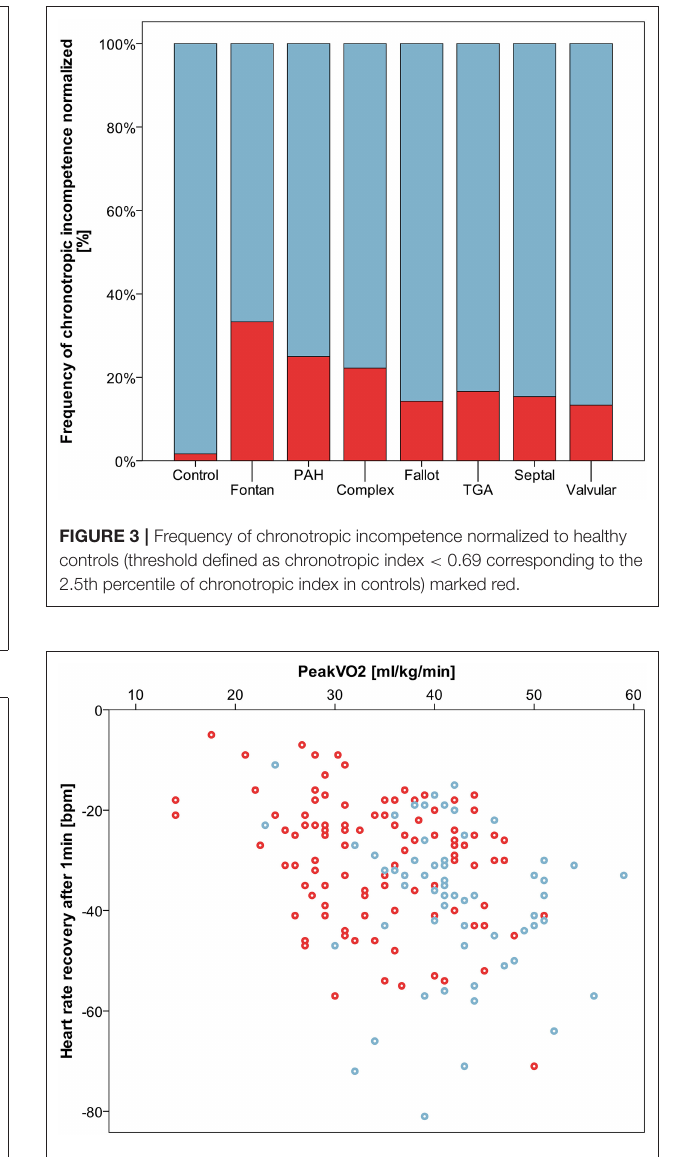
FIGURE 4 | Correlation between 1min heart rate recovery (HRR) and peak oxygen consumption (peak VO 2 ). Spearmans-rho correlation coefficient − 0.35. Controls displayed blue, congenital heart disease